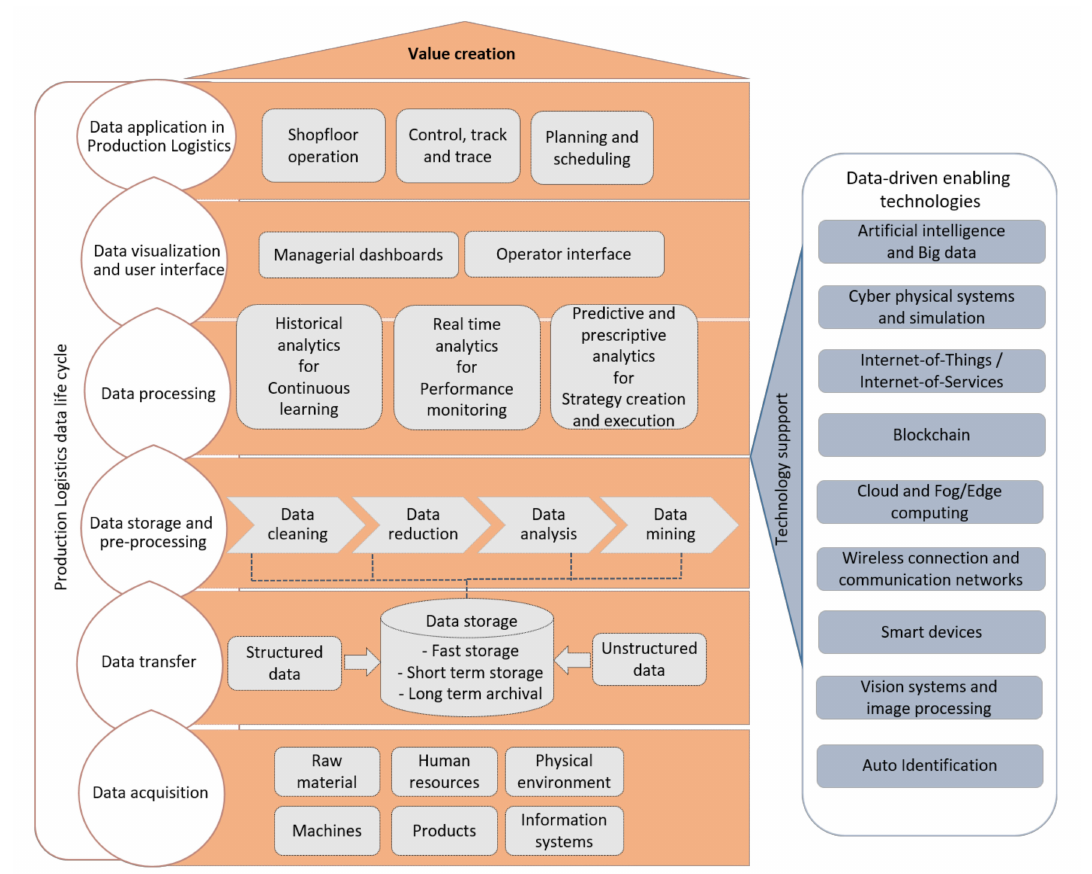
Figure 5. Data life cycle in production logistics adopted from